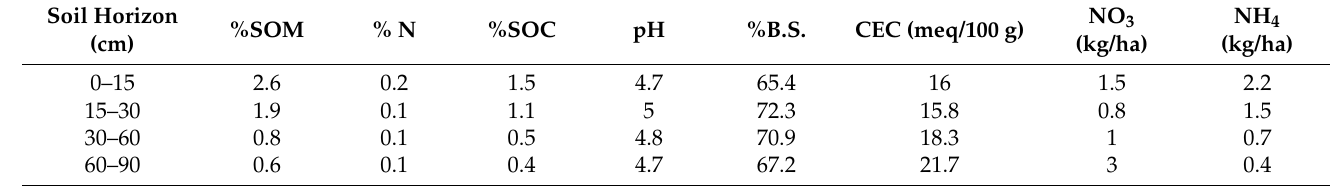
Table 2. Selected measured chemical properties of the soil profile before applying the N rates. Soil